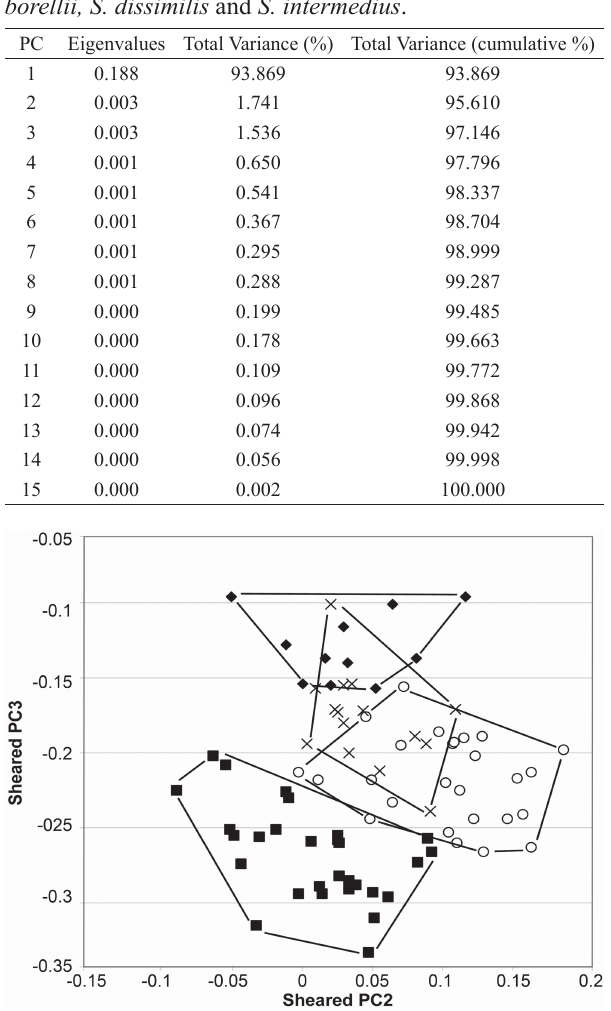
Fig. 1. Scatterplot of the individual scores of combined samples of Schizodon fasciatus (X), S. borellii (white circles); S. dissimilis (diamonds), and S. intermedius (black squares) on the second and third axis of the sheared principal component analysis (PCA).